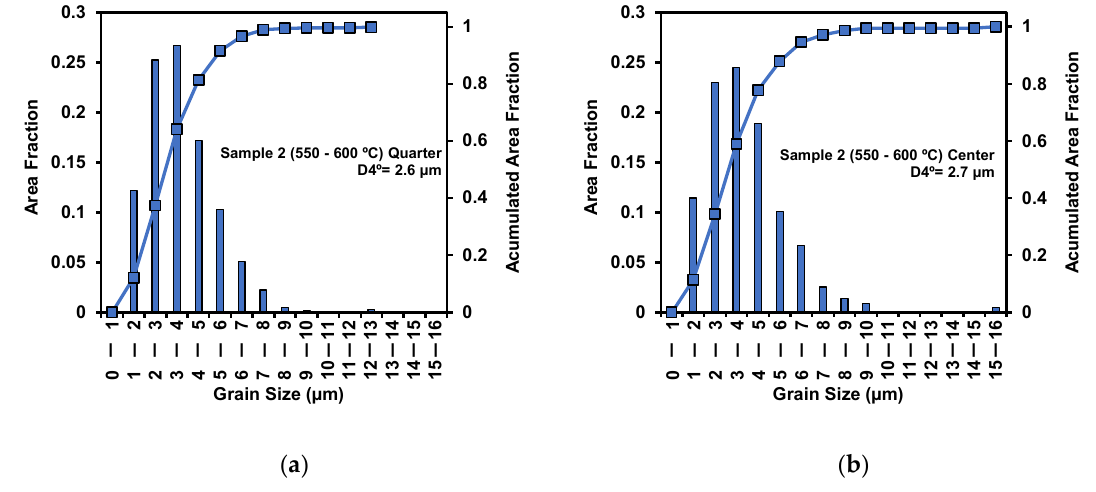
Figure 7. Grain size distribution obtained in Sample 2 (coiling temperature of 550–600 °C) at different locations along the thickness: ( a ) quarter and ( b ) center of the thickness.